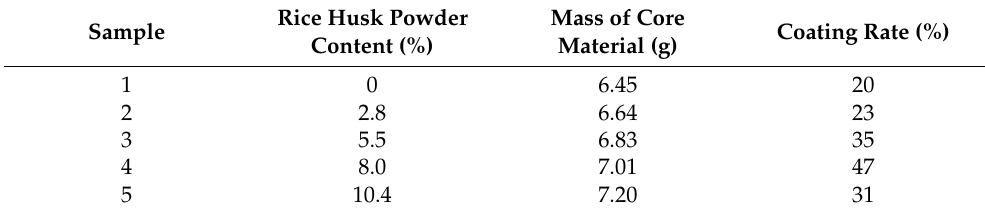
Table 8. Results of microcapsule coating rate in the single-factor